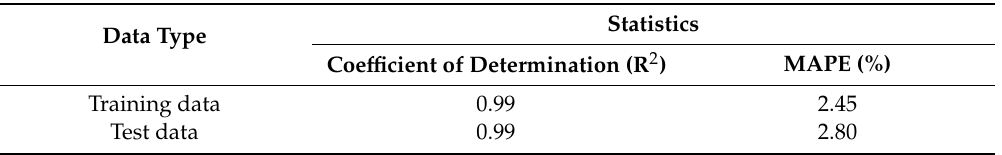
Table 6. Evaluation results of coefficient of determination and MAPE of DNN model with five hidden layers and 40 hidden layer nodes for ore production prediction.